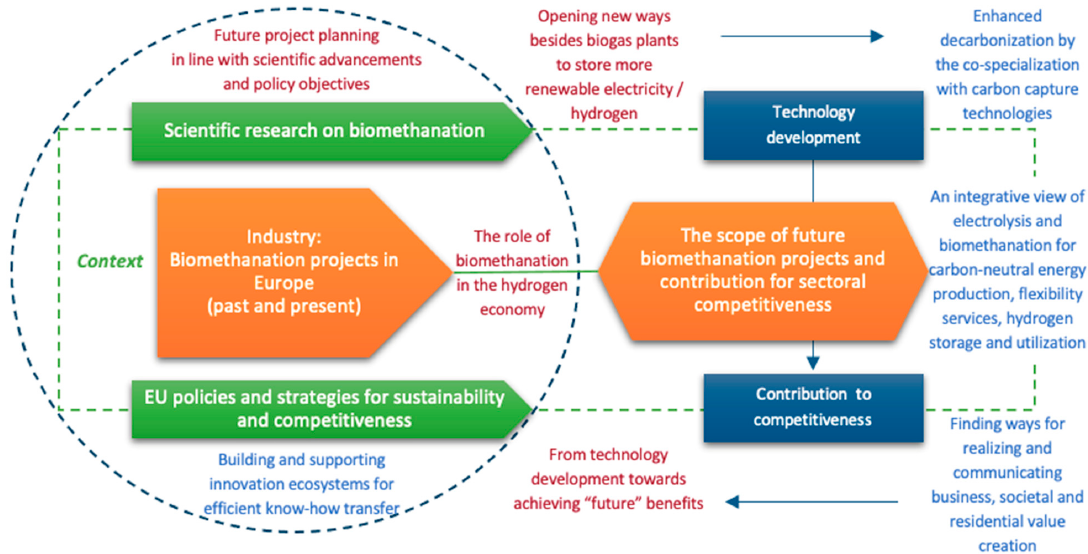
Figure 7. Findings aligned by the research framework (Orange: Focus of the research; Green: Context of the research; Red: Key topics; Blue: Suggested R&D&I directions).